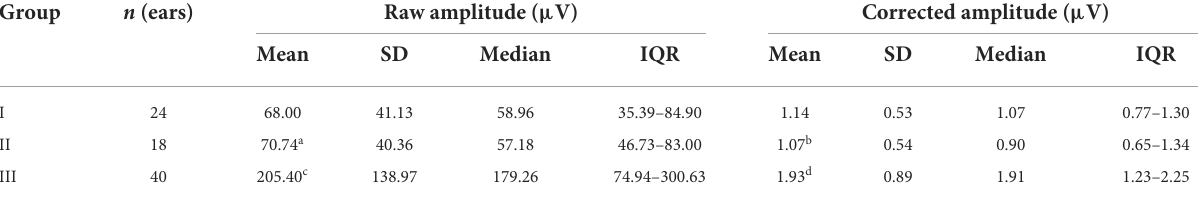
TABLE 5 The raw and corrected amplitudes of ACS-cVEMP in three groups.